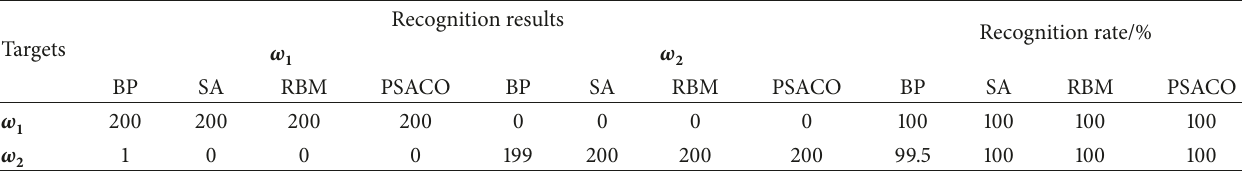
Table 7: Recognition results of CNIS-I for damaged sample.